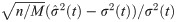
Empirical distribution of the normalized asymptotic error.The panels show the empirical distribution of n/M(σ^2(t)−σ2(t))/σ2(t) for t ≈ 0.15 left panels, t ≈ 0.5 middle panels, t ≈ 0.9 right panels and c = 1/2 upper panels, c = 1/8 lower panels with 1-second returns.